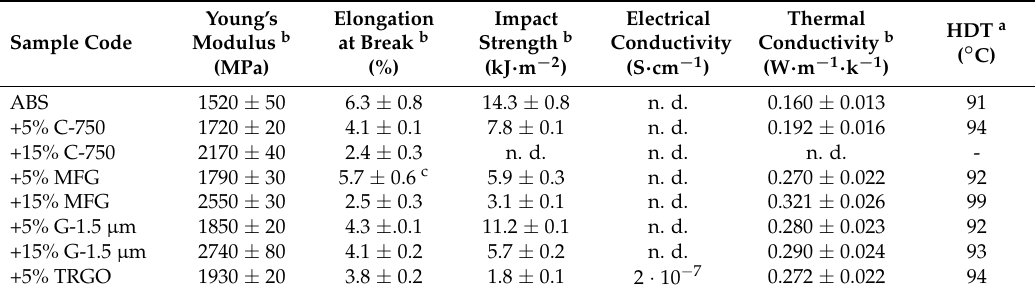
Table 3. Properties of carbon/ABS nanocomposites.